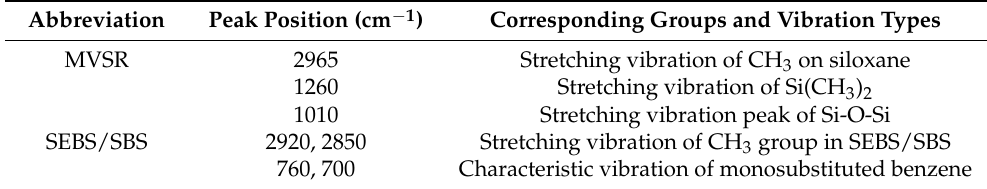
Table 2. Infrared characteristic peaks of MVSR and